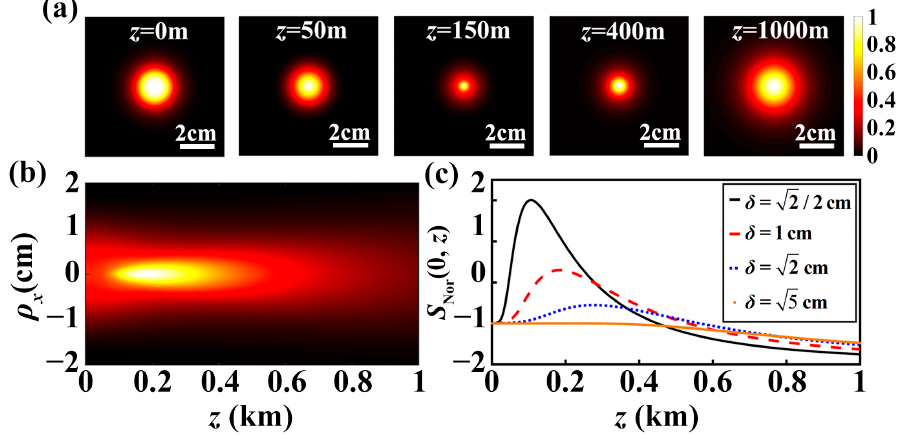
Figure 2. Evolution of the normalized spectral intensity on propagation in free space, ( a ) in ρ x ‐ ρ y cross ‐ section; ( b ) at ρ x ‐ z cross ‐ section; ( c ) on ‐ axis.